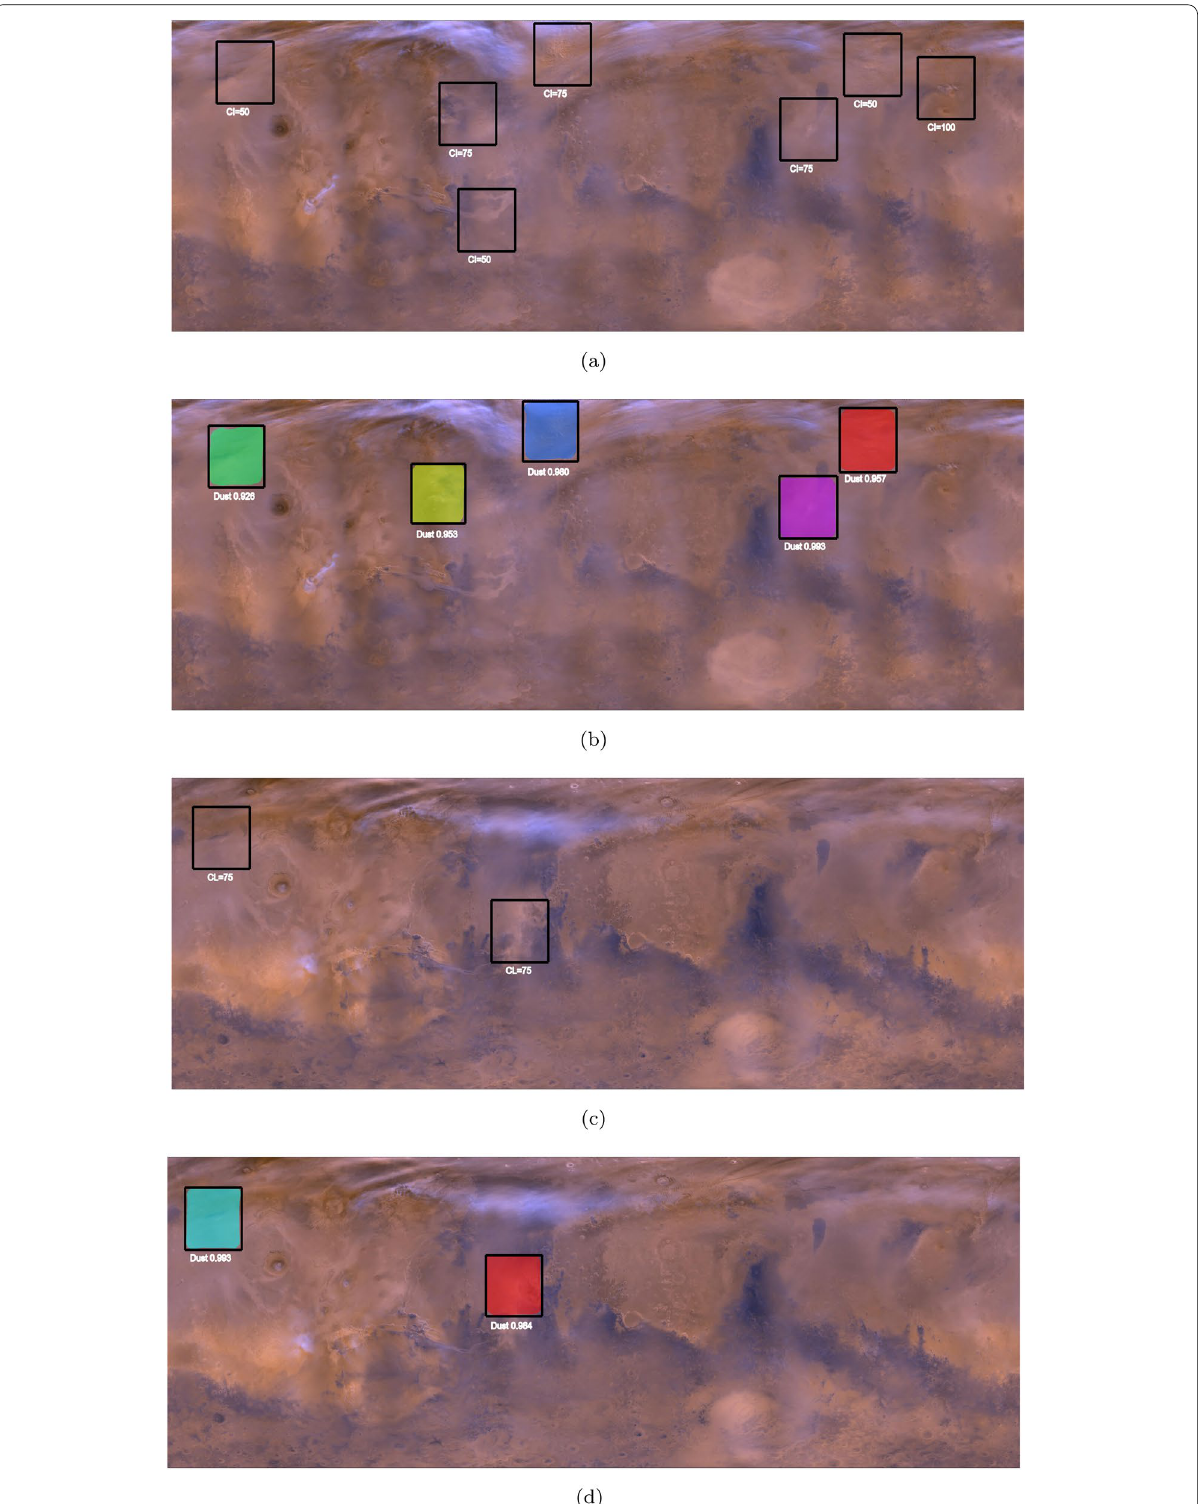
Fig. 4 1st strategy: the training and validation images are selected randomly from MY 25 to middle of MY 27. The testing images are selected randomly from middle of MY 27 to MY 28. a and c are ground-truth images from fall season ( s 20_011 ) at L S = 222.83 ◦ and winter season ( s 11_018 ) at L S = 305.93 ◦ , respectively. b and d are their predicted dust